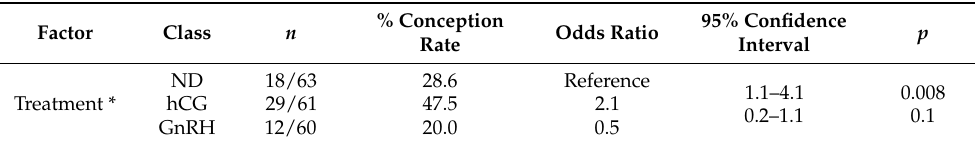
Table 2. Odds ratios of the variables included in the final logistic regression model for factors affecting conception rate after